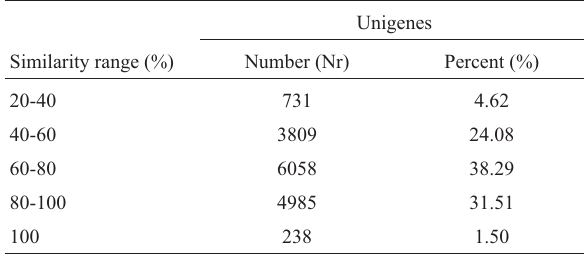
Table 5 - Similarity distribution of L. dispar unigenes with sequences in the Nr